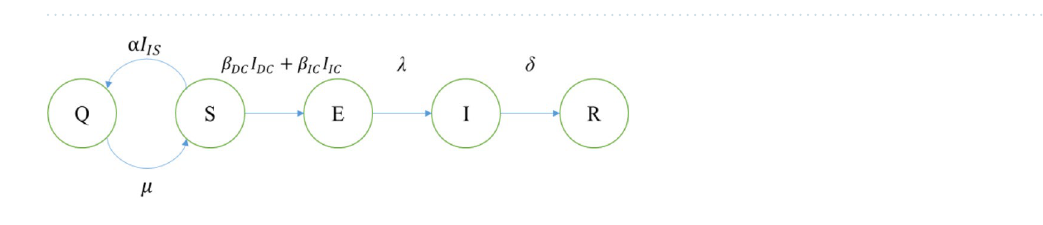
Figure 3. Node degree distributions of different networks.